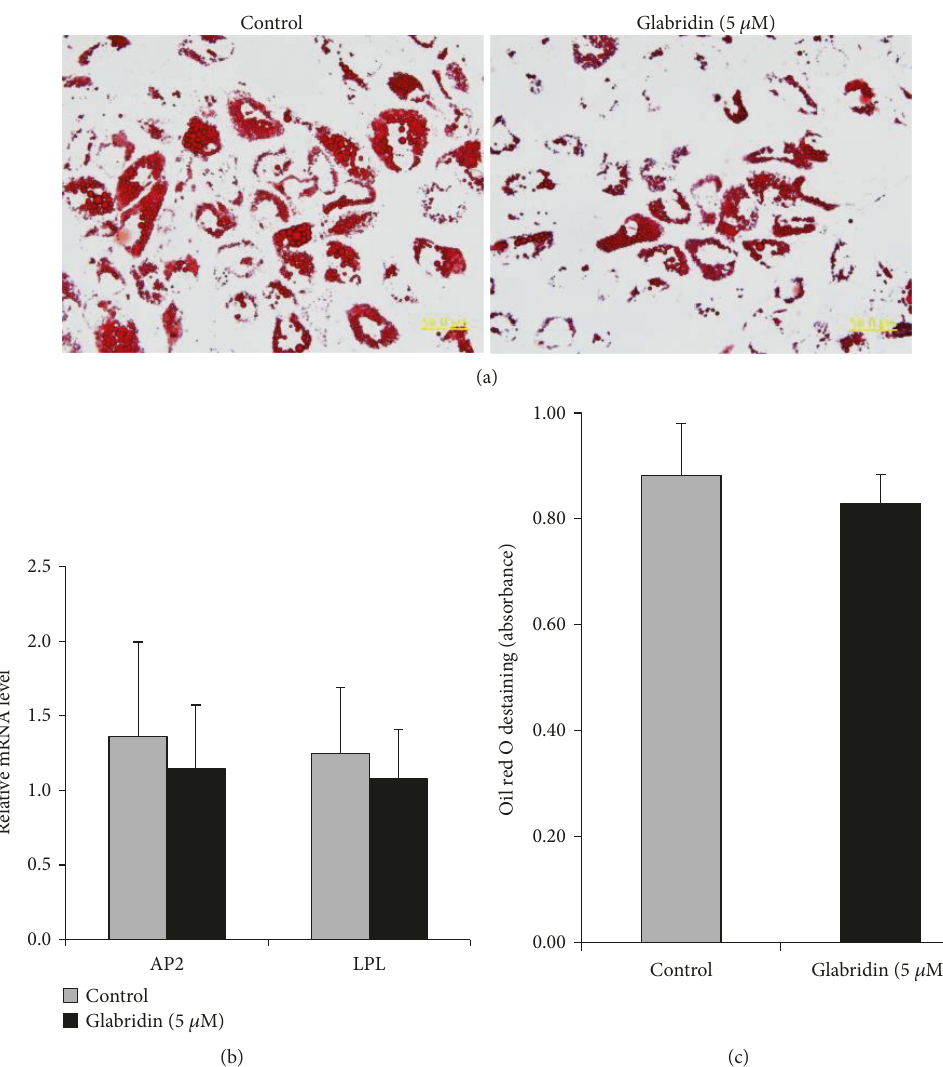
Figure 6: E ff ect of glabridin on adipogenesis in MSCs. (a) Adipogenic di ff erentiation was evaluated by oil red O staining (magni fi cation: 400x). (b) Adipogenic capacity was analyzed by AP2 and LPL mRNA expression using RT-PCR. (c) Absorbance was determined after oil red O destaining for quantitative analysis. The data are expressed as the mean ± SD of three